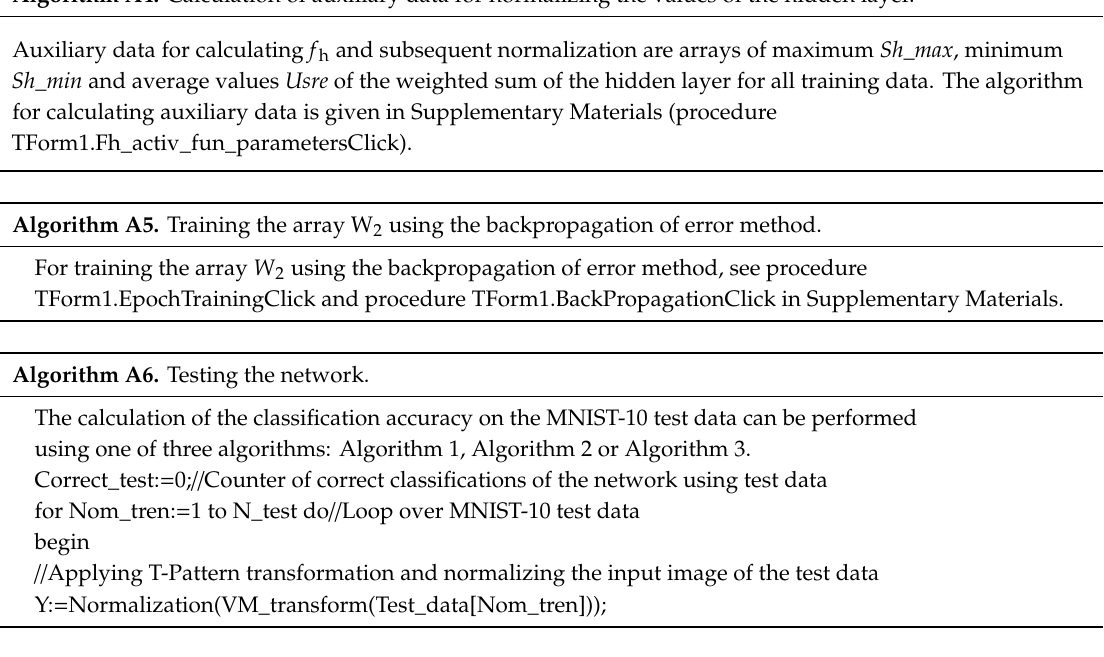
Algorithm A4. Calculation of auxiliary data for normalizing the values of the hidden layer.